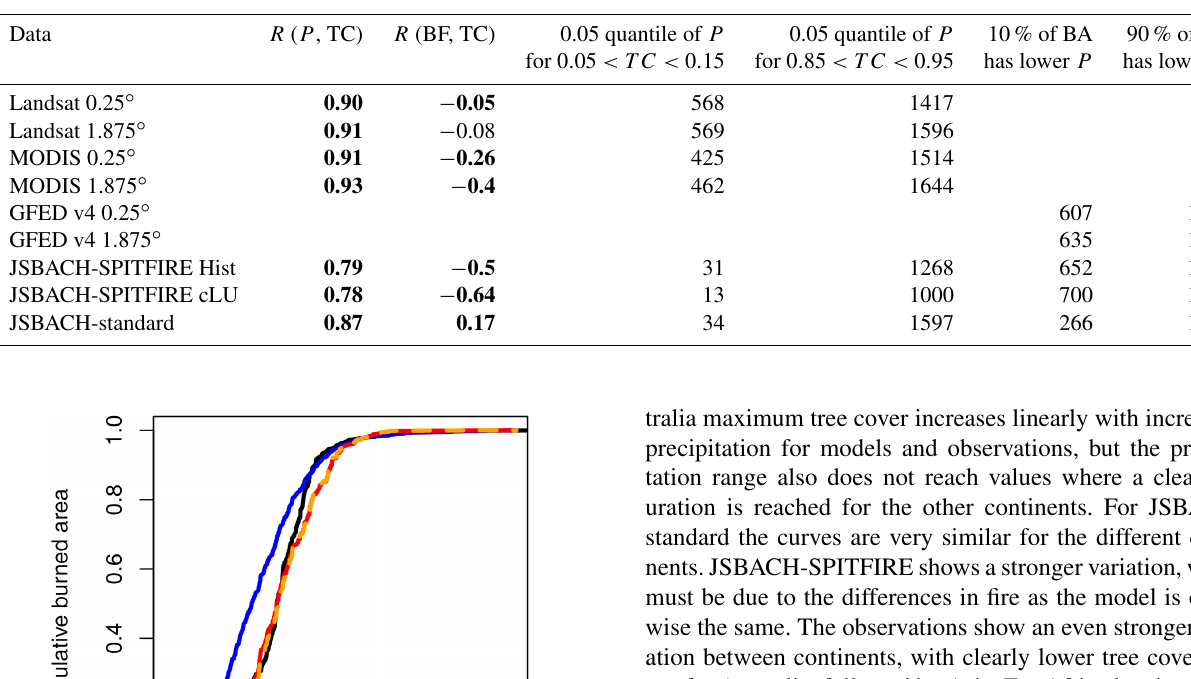
Table 1. Spearman rank correlation ( R ) between precipitation ( P ) and tree cover (TC), and rank correlation between burned fraction (BF) and TC for data points with mean annual precipitation higher than 1000mm and tree cover less than 0.8. The required precipitation (mmyear − 1 ) for 0 . 05 < TC < 0 . 15 and 0 . 85 < TC < 0 . 95, estimated as 0.05 quantile of precipitation for grid cells with the specific TC only, and precipita- tion value (mmyear − 1 ), where 10% and 90% of the burned area (BA) originates from areas with lower precipitation. For the remote-sensing data sets TMPA was used as precipitation, for the simulations (Hist, cLU, and JSBACH-standard) the MPI-ESM precipitation was used. Model results are all in 1.875 ◦ resolution. Bold font indicates significance ( p value < 0 . 05) of the correlation.